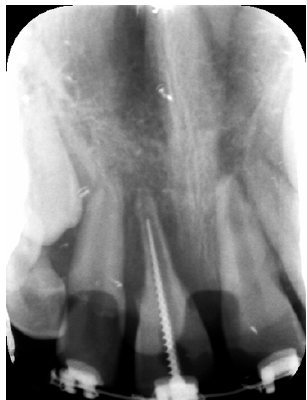
Figure 2. Periapical radiograph during root canal treatment demonstrating an aggressive external root resorption of tooth 11.